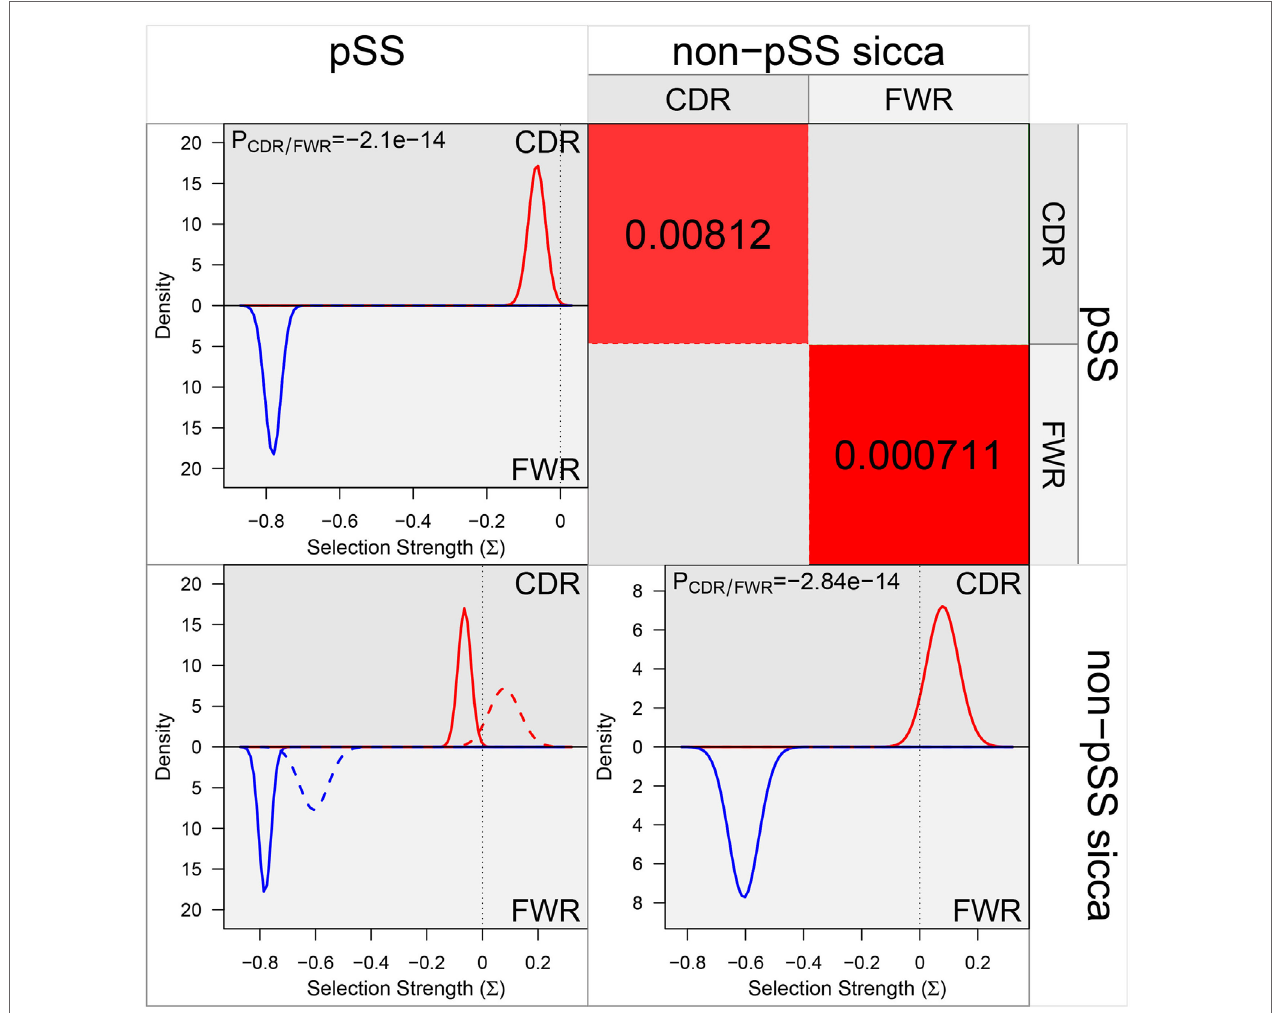
FigUre 4 | The selection pressures on IGHV sequences derived from dominant clones in pSS patients and non-pSS controls. All individual sequences from the dominant clones from pSS and non-pSS control parotid gland biopsies were inserted into the BASELINe program and the selection strength of both groups were compared. The figure is obtained as output data from the BASELINe program. The red line in the upper left plot represents the selection strength of the pSS sequences in the complementarity determining regions (CDRs). The blue line represents the (negative) selection strength in the framework (FWR) regions. In the lower right plot, the red line represents the selection strength of the non-pSS control sequences in the CDRs and the blue line the strength in the FWRs. The lower left plot is an overlay plot in which the solid line is the selection strength for pSS and the dashed line for non-pSS. Significance of differences in selection pressures was calculated both for CDRs and FWR regions between pSS and non-pSS samples in the upper right